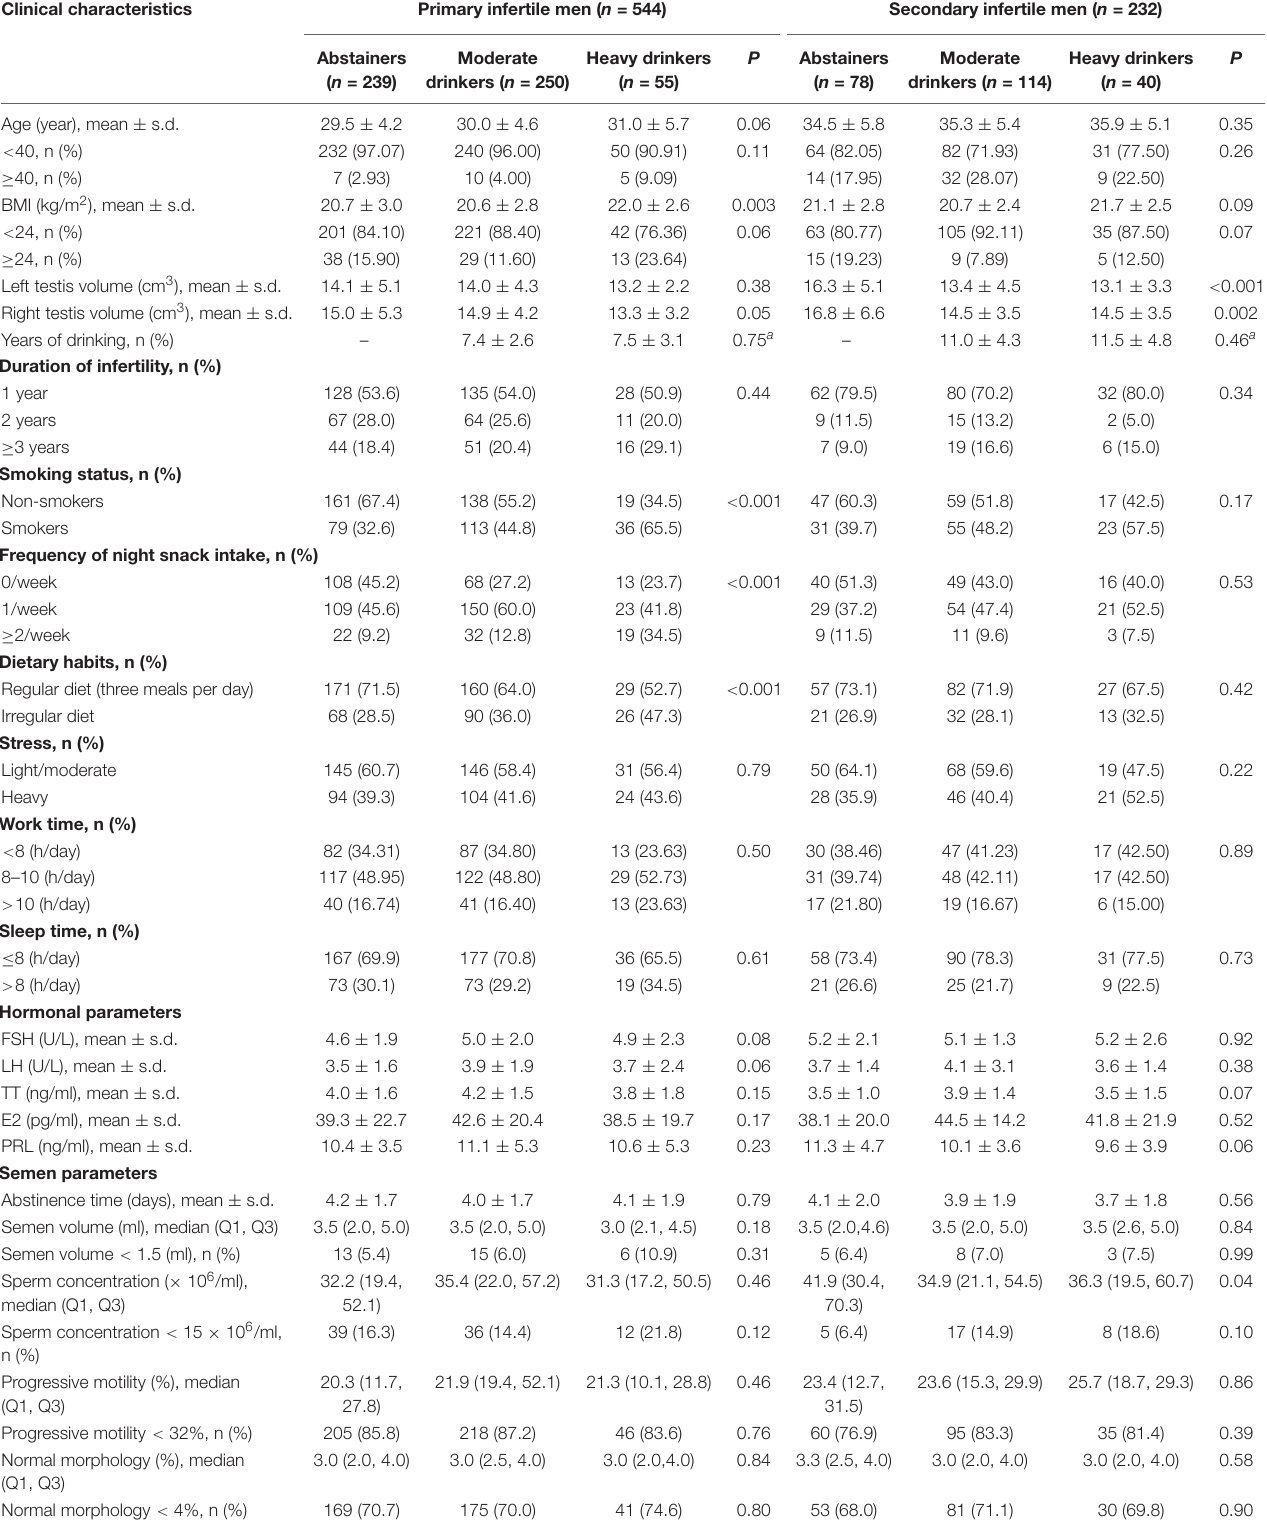
TABLE 2 | Descriptive statistics according to alcohol status for the entire